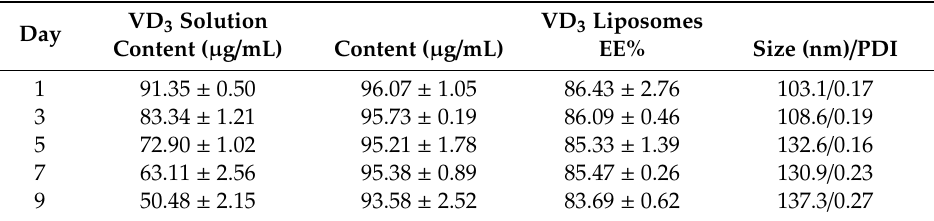
Table 6. The stability of VD 3 liposomes in 25 ◦ C and 4500 Lx light.